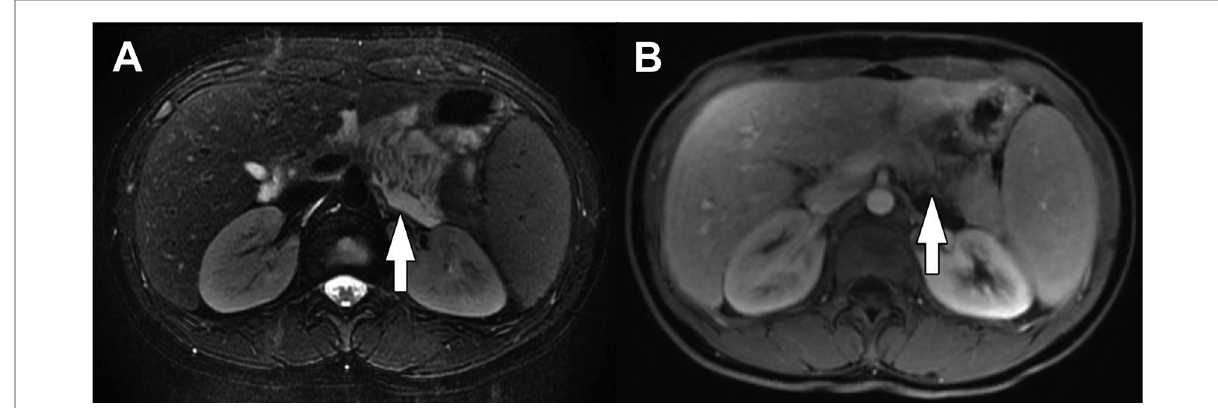
FIGURE 9 Lymphatic malformation. ( A ) Axial T2-weighted fat-saturated MRI and ( B ) Axial T1-weighted fat-saturated post-contrast MRI show an in fi ltrative lesion involving the body of the pancreas (arrows). The lesion is T2-weighted hyperintense re fl ecting fl uid content without enhancement following contrast administration. Transspatial involvement is characteristic of a lymphatic